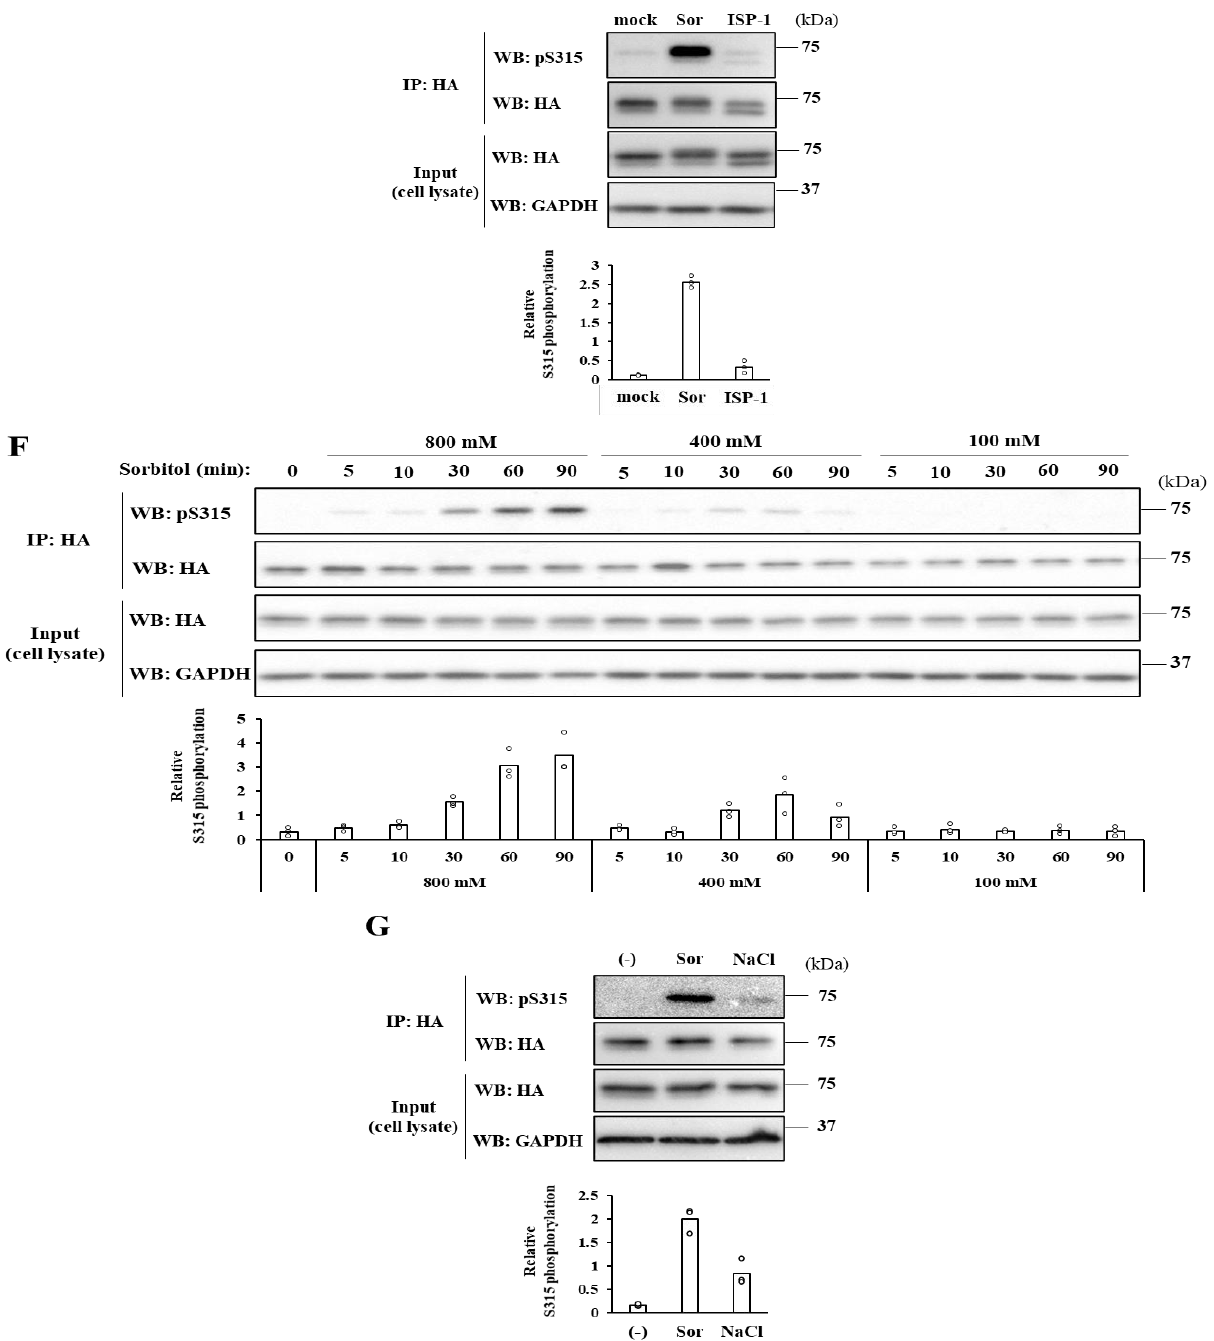
Figure 1. Hyperosmotic stress induces the phosphorylation of CERT S315 residue without changing the SRM-phosphorylation state. ( A ) The established cell lines expressing HA-CERT wild-type (WT) or S315A mutant with near endogenous level. The cells were lysed and immunoblotted with the respective antibodies against CERT, HA-epitope, and the loading control GAPDH. ( B ) The S315 phosphorylation of CERT was monitored using a phosphorylated S315 (S315p)-specific antibody. CERT KO/shCERT HeLa cells expressing HA-CERT WT or S315A mutant with near endogenous level were treated with 600 mM sorbitol for 1 h. The lysates were subjected to immunoprecipitation with HA-agarose, and the eluates were immunoblotted with the respective antibody against S315p and HA. The magnified area shows the CERT doublet due to its phosphorylation states of the SRM. Two independent experiments were carried out, and similar results were